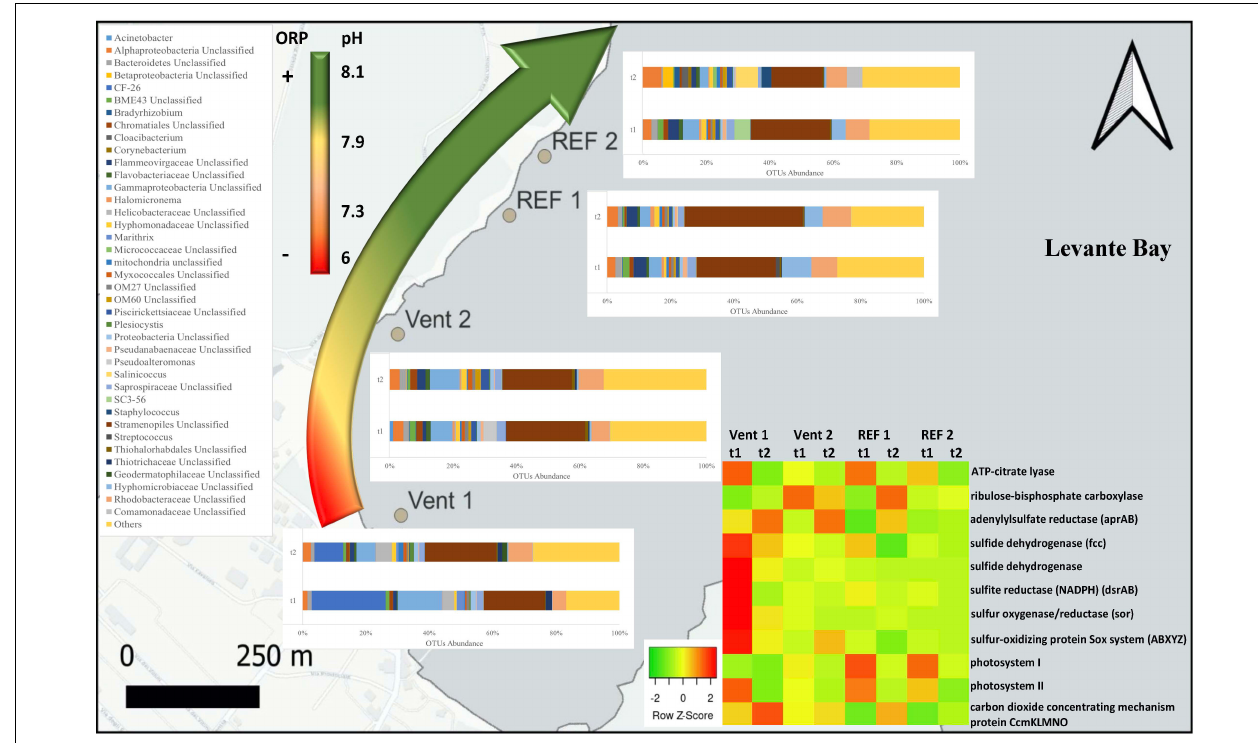
FIGURE 2 | Genus-level taxonomic affiliation of 16S rRNA transcripts recovered from the biofilms located at the four study sites of Levante Bay, Vulcano island. Taxa representing genera that account for at least 1% (on average) of the overall abundance in all samples are shown. The curved arrow on the left indicates the redox (ORP) and pH observed along the p CO 2 /pH gradient. The heatmap on the right shows the abundance of genes for inferred central metabolic pathways of the biofilms.